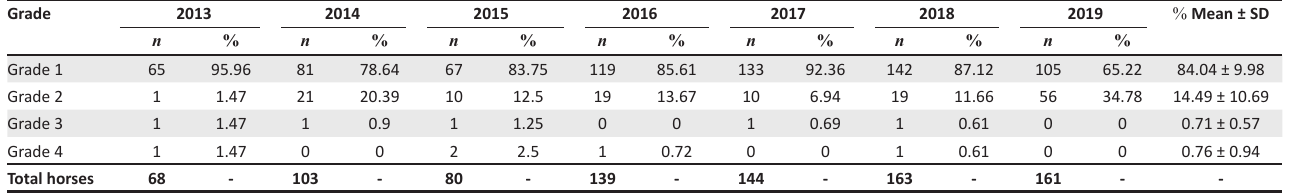
TABLE 3: Endoscopic examination grading of recurrent laryngeal neuropathy of yearlings at South African sales from 2013 to 2019. Grade